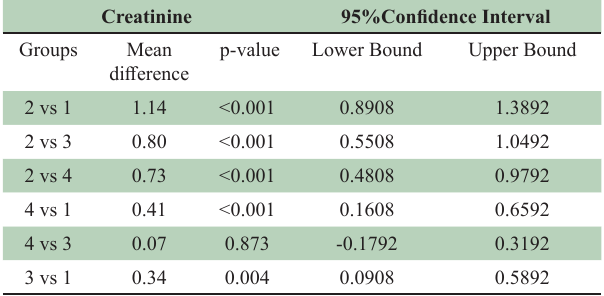
Table-IV: Post-Hoc Tukey test showing a comparison of urea between groups on day